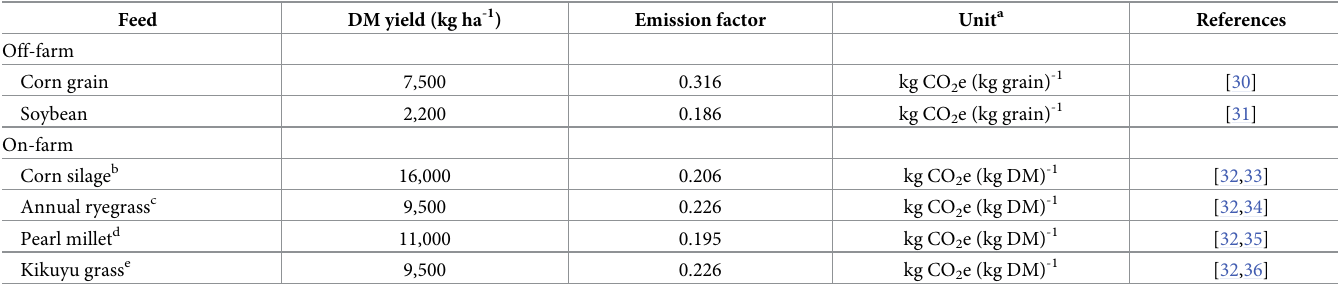
Table 3. GHG emission factors for Off- and On-farm feed